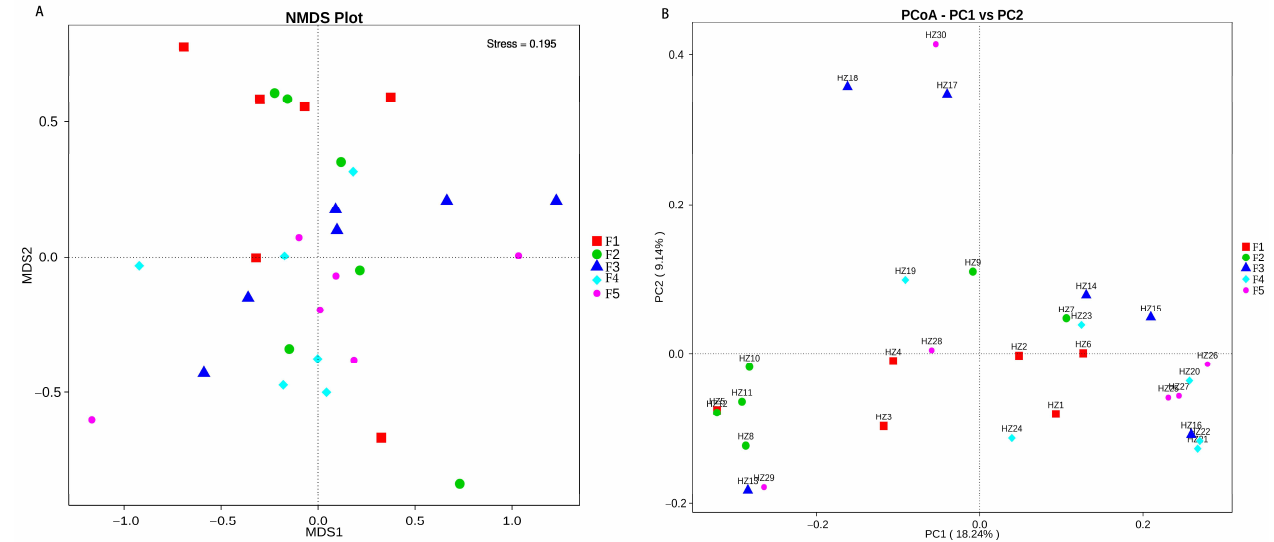
Figure 6. Non-metric multidimensional scaling analysis (NMDS) (PCA; ( A )) and the principal coordinate analysis (PCoA; ( B )) of the fecal microbiome composition. Each point represents the fecal microbiome of a black-billed capercaillie sample.